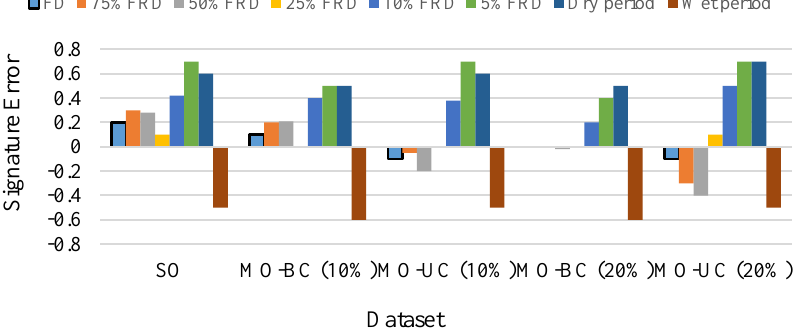
Figure 20. Mean streamflow errors based on observations and simulations of five datasets using two main calibration approaches (SO & 4 algorithms parameterization of MO-SB).